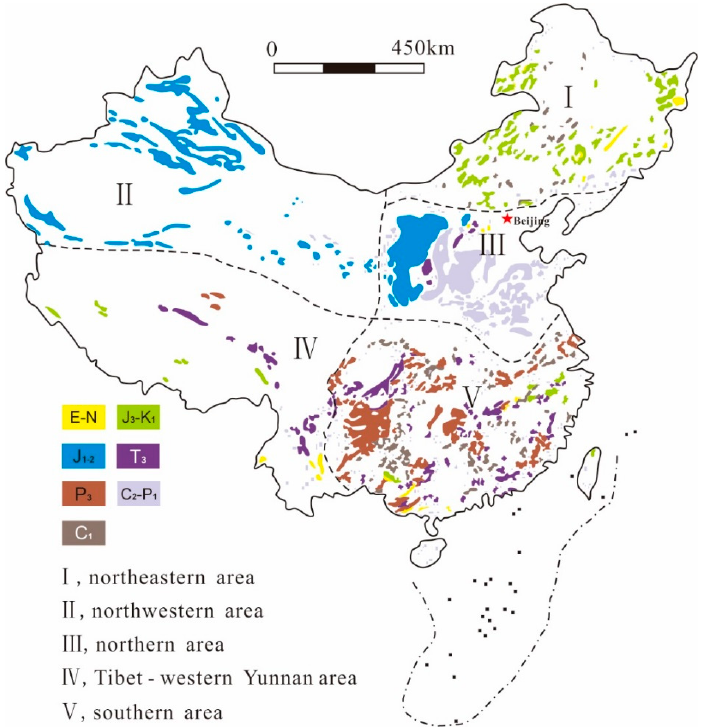
Figure 1. Coal-distribution areas in China, modified from Dai et al. [13].